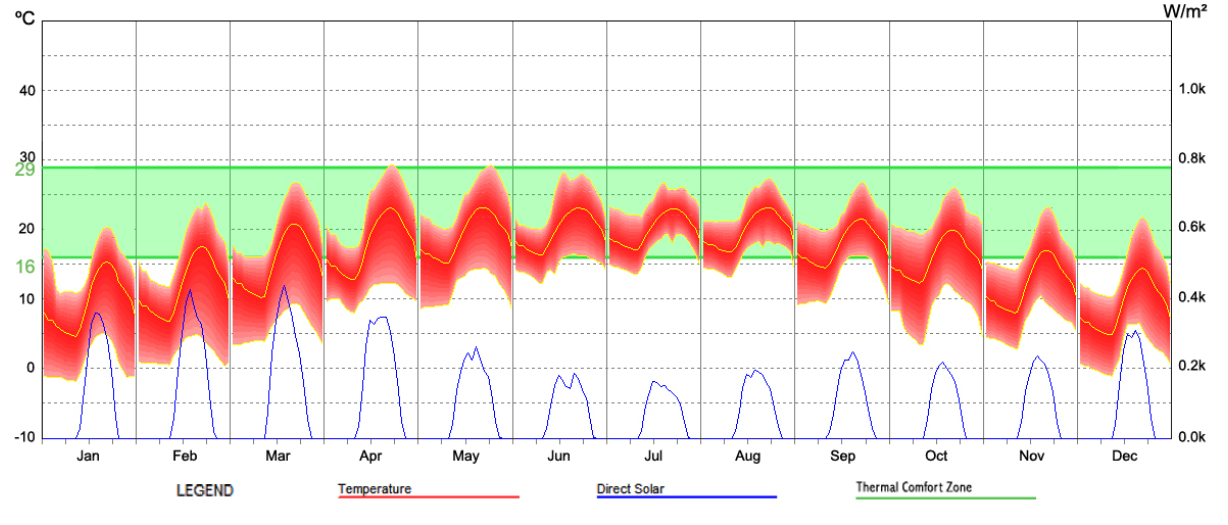
Figure 25. Kunming Climate Data, (MeteonormV6.1 data period: